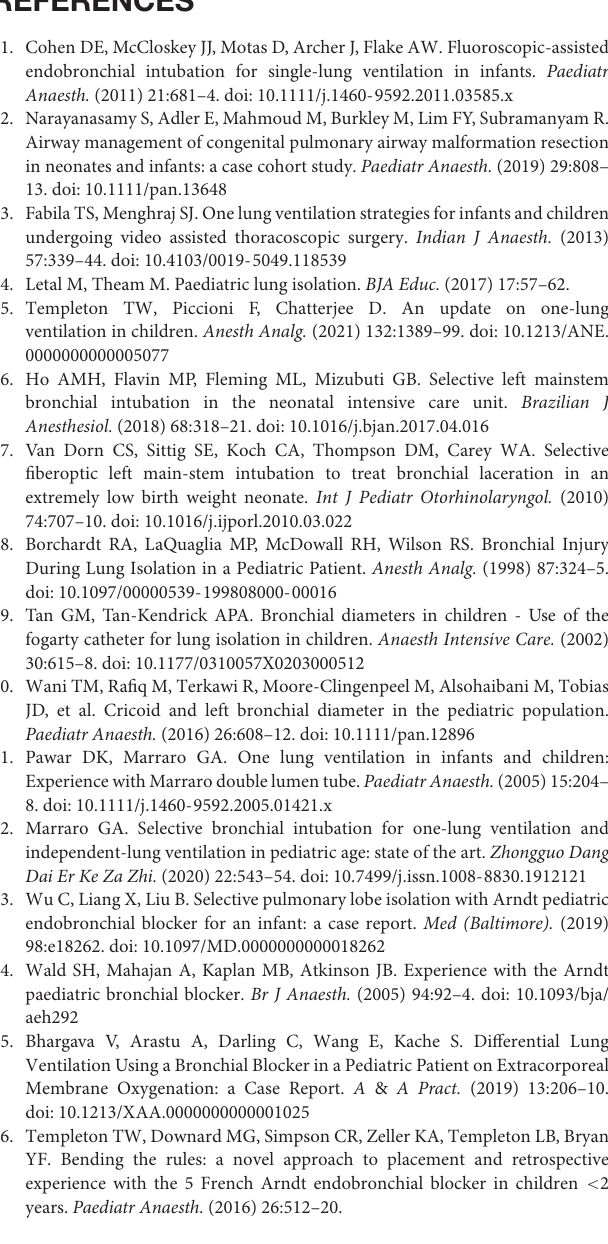
Supplementary Document 1 | ARRIVE set document. Supplementary Visual Abstract | The study introduced an exclusive ultrasound-guided bronchial intubation with a reinforced single lumen tube and bronchial exclusion with a bronchial blocker technique on rabbit pediatric model. Further advanced experimental studies are needed for translation to pediatric